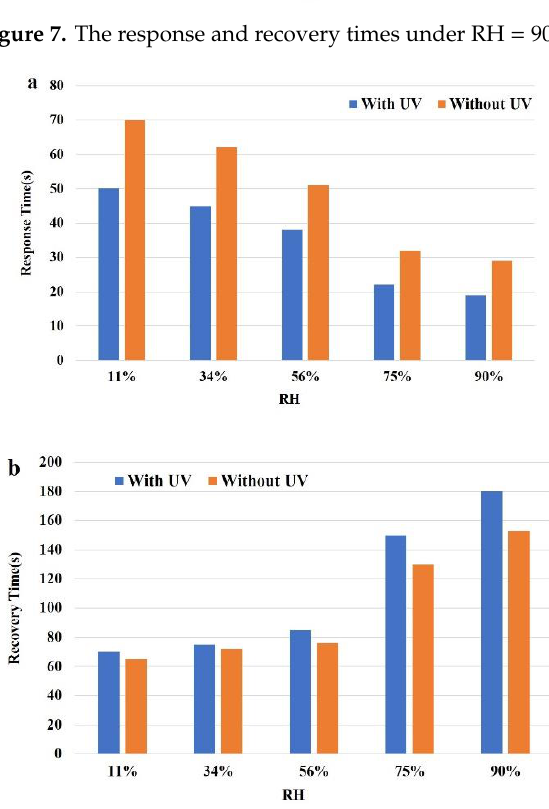
Figure 8. ( a ) The response time of the SnO 2 /silicon nanopillar array sensor. ( b ) The recovery time of the SnO 2 /silicon nanopillar array sensor.